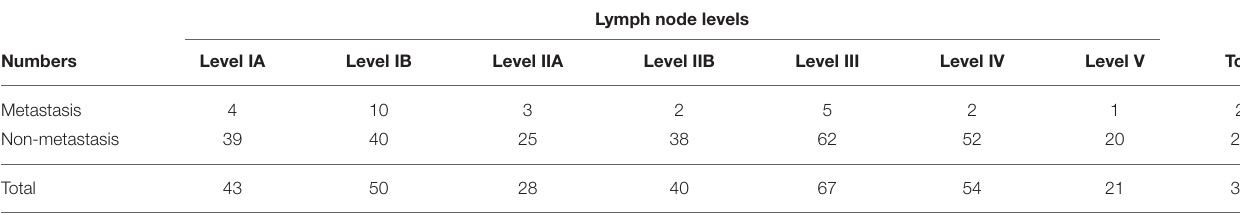
TABLE 2 | Results of histopathologic examination of various cervical lymph node levels.